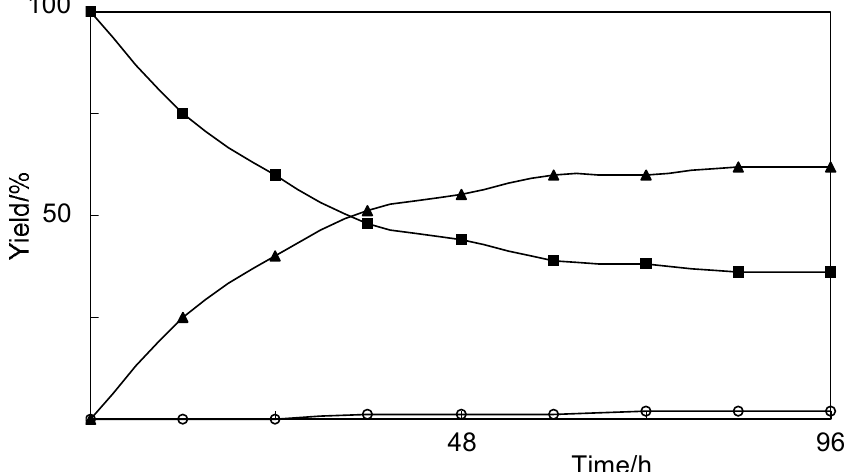
Figure 2. Time course of the biotransformation of 8-nordihydrocapsaicin ( 5 ) by cultured cells of E. perriniana . Yields of 5 ( ■ ), 6 ( ▲ ), and 7 ( ○ ) are plotted.